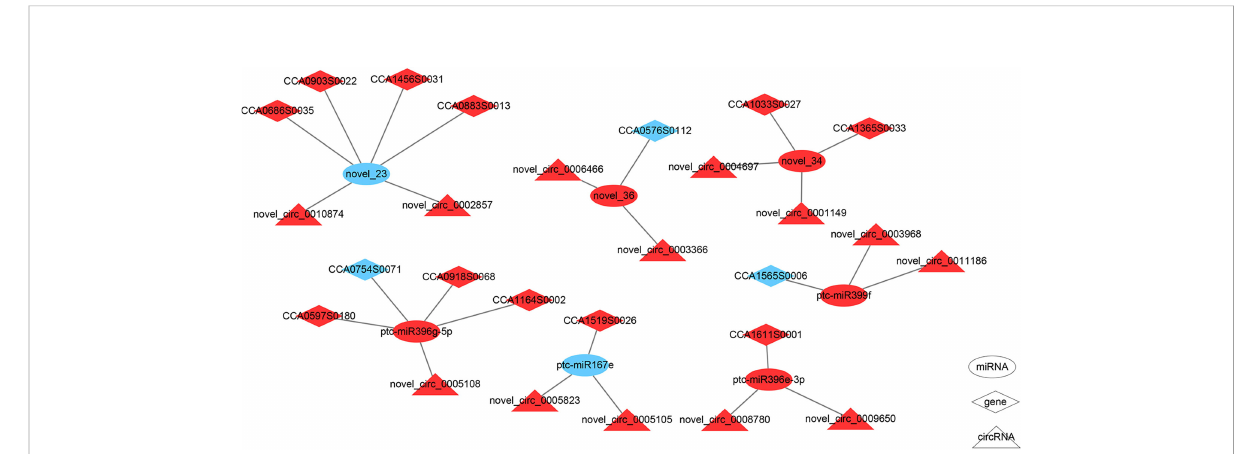
FIGURE 4 The circRNA-miRNA-mRNA regulation network in F1 compared with F2. The ellipses, diamonds, and triangles denote miRNAs, genes, and circRNAs, respectively. The red denotes upregulation and the blue denotes downregulation.